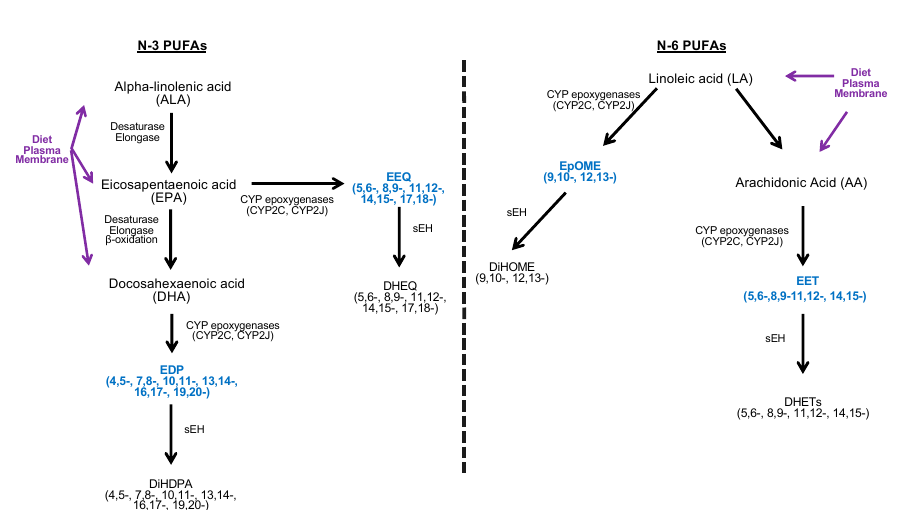
Figure 1. Overview of metabolic pathway of CYP-derived epoxylipids. LA, AA, ALA, EPA, and DHA are essential dietary fatty acids and are found in membrane phospholipids. AA: arachidonic acid; ALA: α -linolenic acid; CYP: cytochrome P450. DiHOME: dihydroxyoctadecenoic acid; DHA: docosahexaenoic acid; DiHDPA: dihydroxydocosapentaneoic acid; DHEQ: dihydroxyeicosatetraenoic acid; DHET: dihydroxyeicosatrienoic acid; EET: epoxyeicosatrienoic acid; EDP: epoxydocosapentaenoic acid;